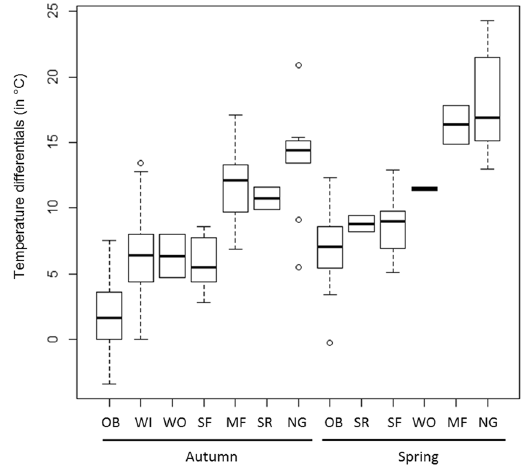
Figure 6. Boxplot showing the differences (average, box of 25 th and 75 th quartiles, and 5%-95% confidence intervals) in maximum temperature recorded on a day of prolonged nocturnal flight compared to the maximum temperature recorded at the same hour the previous day, or on the next day that occurred without a prolonged flight during daylight. Labels of the x-axis are codes for species names and seasons: OB: ortolan bunting, WI: willow warbler, WO: wood warbler, SF: spotted flycatcher, MF: Mediterranean flycatcher, SR: rufous-tailed scrub-robin, NG: